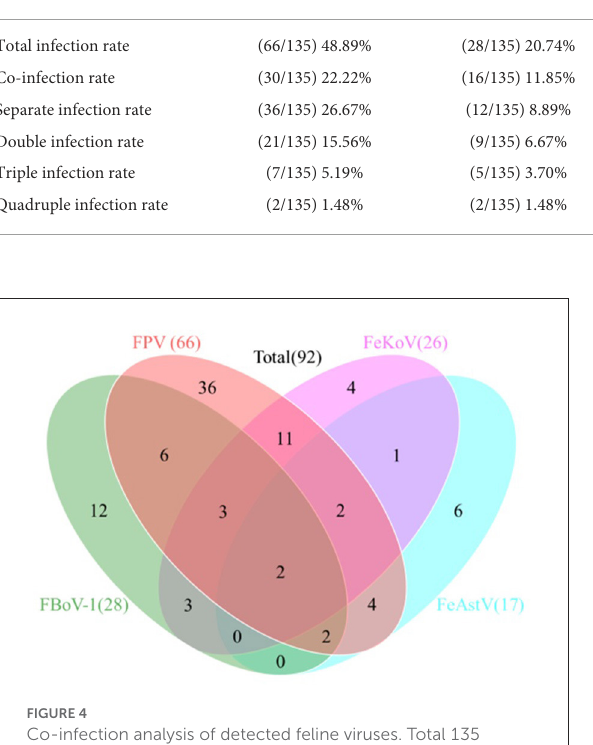
FIGURE4 Co-infection analysis of detected feline viruses. Total 135 clinical feline fecal samples collected from 2018 and 2021 were analyzed by the multiplex real-time qPCR assay. A total of 92 samples were detected as positive. The Venn diagram shows the number of samples infected by either single virus or multiple